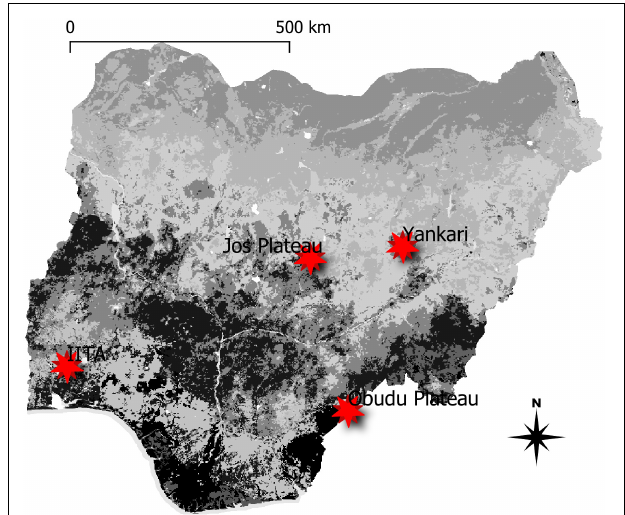
FIGURE 1 | Map of Nigeria with study sites indicated as stars.